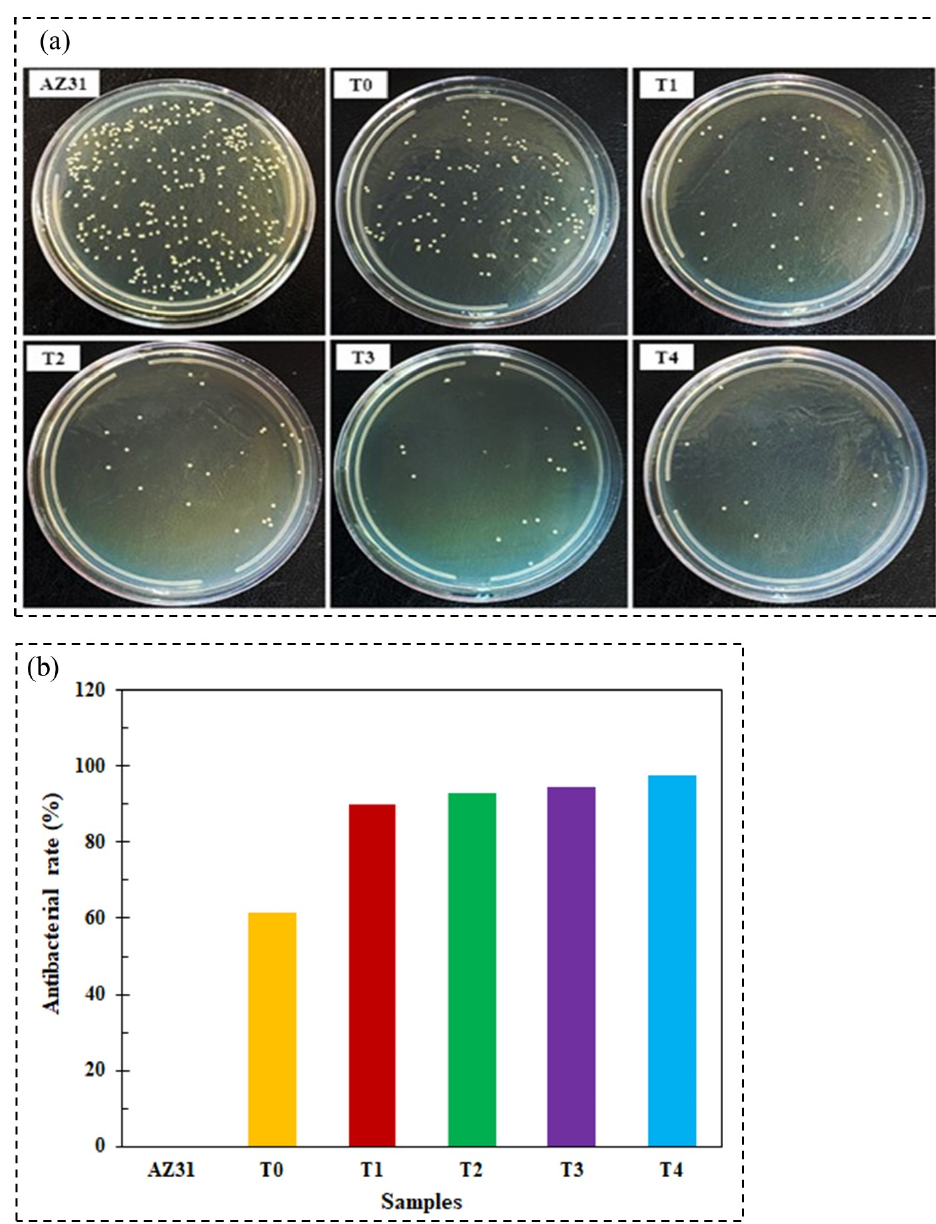
Figure 18. ( a ) The colonies photographs of S. aureus bacteria after 6 h incubation at 37 °C and ( b ) the calculated antibacterial rate graph for PEO coatings.